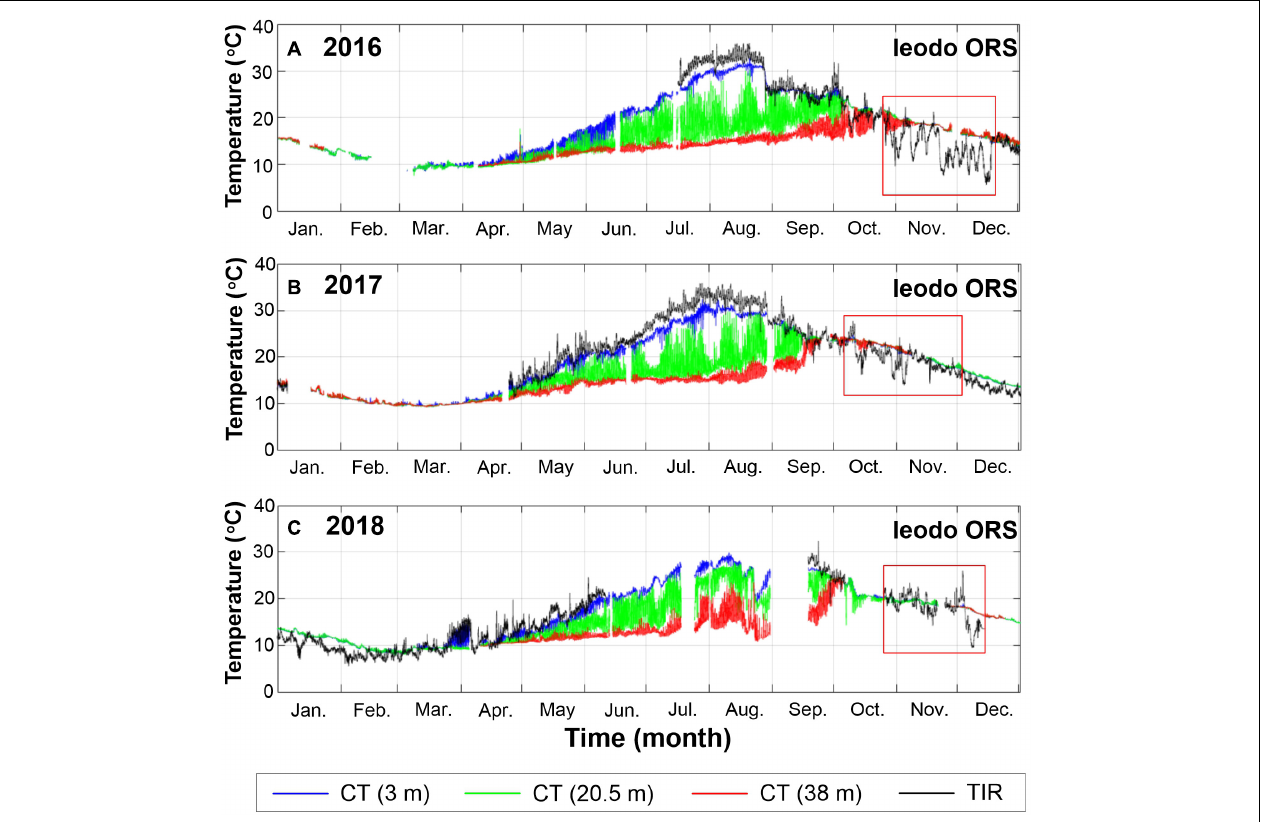
FIGURE 6 | Quality controlled water temperatures measured from Ieodo ORS using conductivity temperature (CT) sensors deployed at depths of 3 m (blue line), 20.5 m (green line), and 38m (red line), along with sea surface temperature (black line) measured using the TIR camera from 2016 to 2018 (A–C) . Rectangular red boxes indicate abnormal SST values observed during the winter